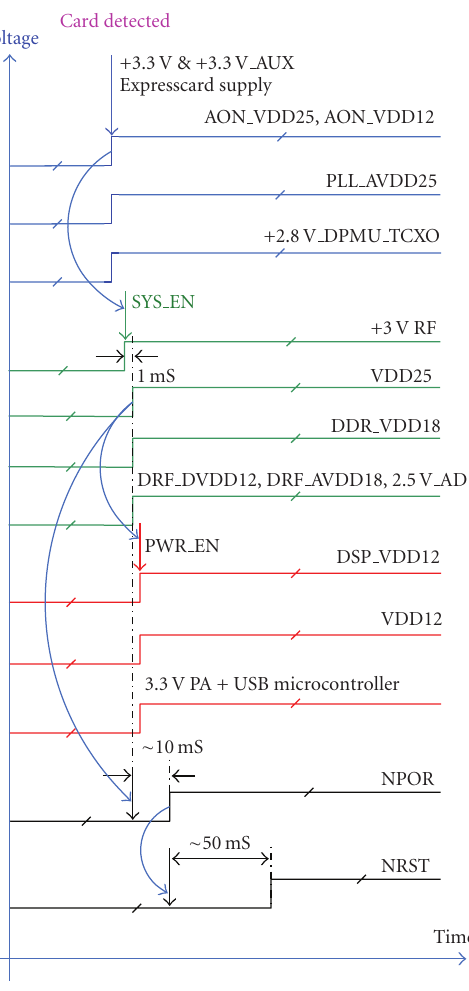
Figure 5: Power up sequence diagram.